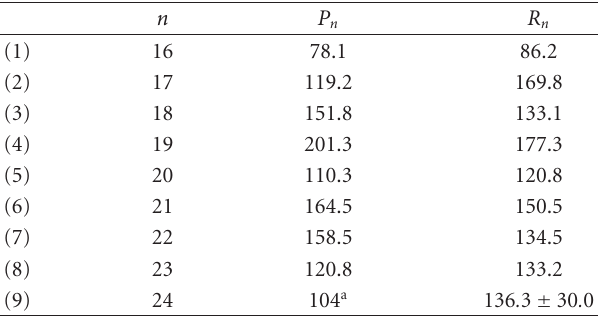
Sunspots appear on the Sun in two bands on either side of the equator that drift toward lower latitudes as each